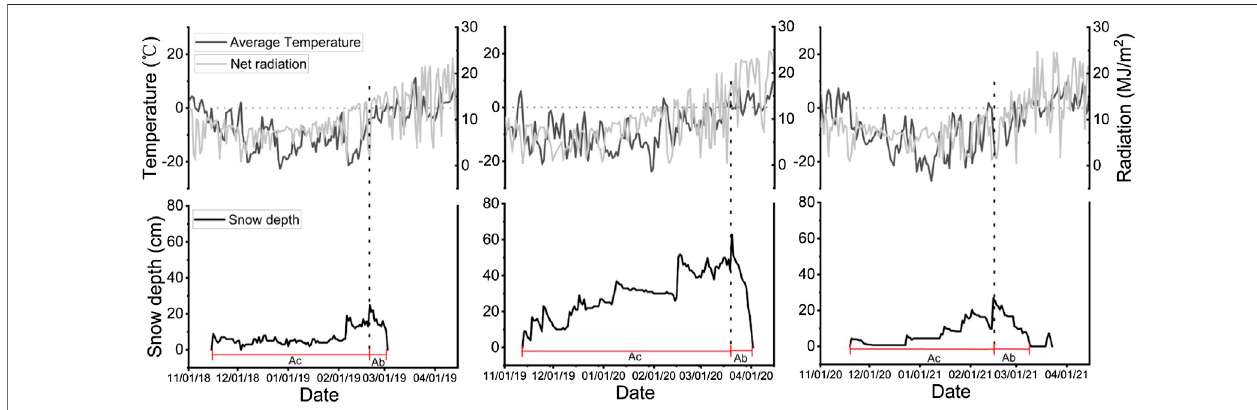
FIGURE 4 | Characteristics of meteorological conditions during snow accumulation and ablation processes in the open area OS, for each of the three winter seasons.Themaximum snowdepthappeared nearthe0 ° Cairtemperature andwasused asthedividingdatefortwoperiods,where Ac istheaccumulation period that occurred before the maximum snow depth date, and Ab is the ablation